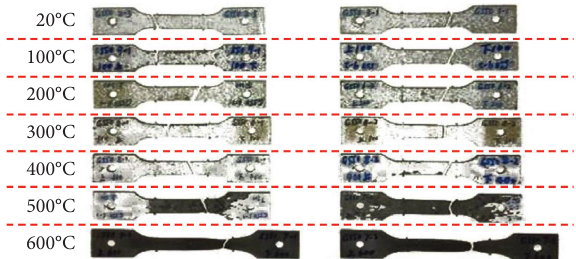
Figure 10: Failure modes for G500 steels.